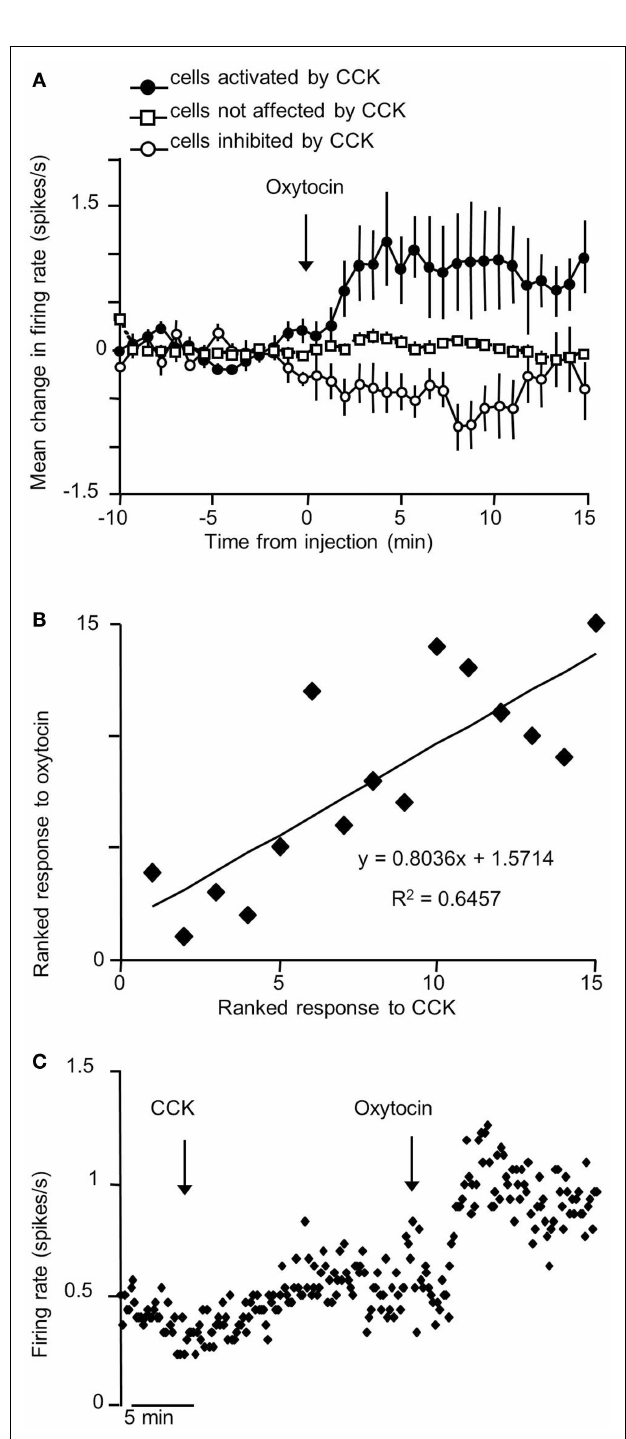
FIGURE 2 | Correlation of responses to icv oxytocin and iv CCK inVMN neurons in vivo . (A) Mean change in firing rate ( ± SE) in response to icv oxytocin (1–10ng) in singleVMN cells that were activated ; n = 5), inhibited ; n = 4), and not affected ; n = 6) by iv CCK injection. (B) Rank correlation of responses to CCK and oxytocin (high ranks excited; low ranks inhibited).The solid line is the linear fit to the ranks ( r 2 = 0.65). (C) Example of convergent responses to icv oxytocin (1–10ng) and iv CCK (20 µ g/kg) in a singleVMN